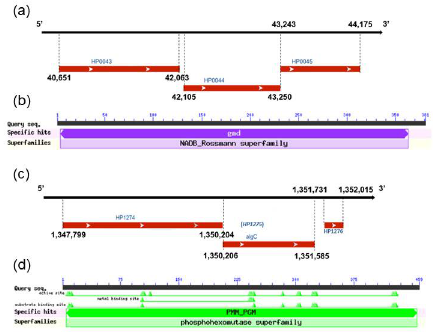
Figure 2. The bioinformatic analysis of the HP0044 and HP1275 genes and the encoded proteins in H. pylori wild-type strain 26695. ( a ) The gene locus of HP0044 . ( b ) The prediction of conserved domains in the HP0044 protein. ( c ) The gene locus of HP1275 . ( d ) The prediction of conserved domain in the HP1275 protein. The data were obtained from the NCBI (https://www.ncbi.nlm.nih.gov/, accessed on 11 December